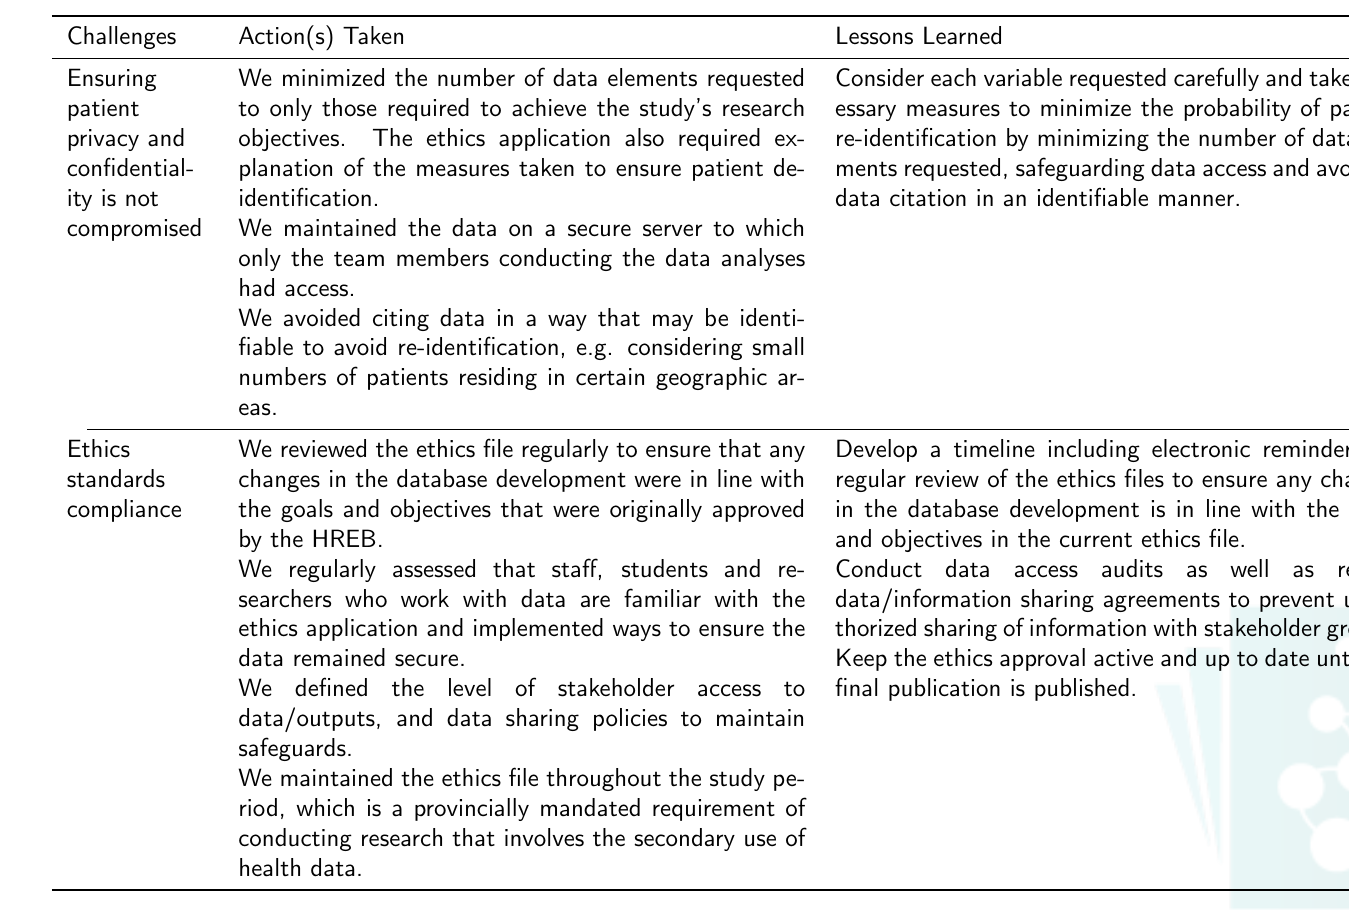
Table 2a: Action(s) taken and lessons learned for challenges that have a potential risk to patient privacy and